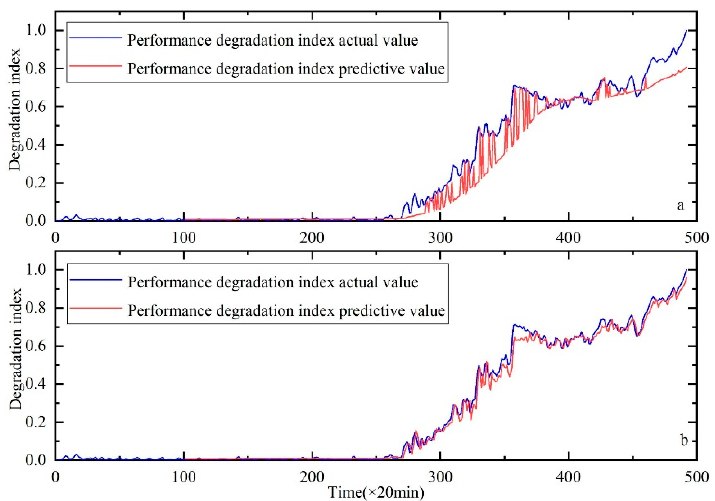
Figure 10. Performance degradation prediction of bearing 4. ( a ) is the result of BPNN, ( b ) is the result of ELM and ( c ) is the result of HKF–SVR with parameters optimized by the KH algorithm. Table 5. Prediction errors comparison.